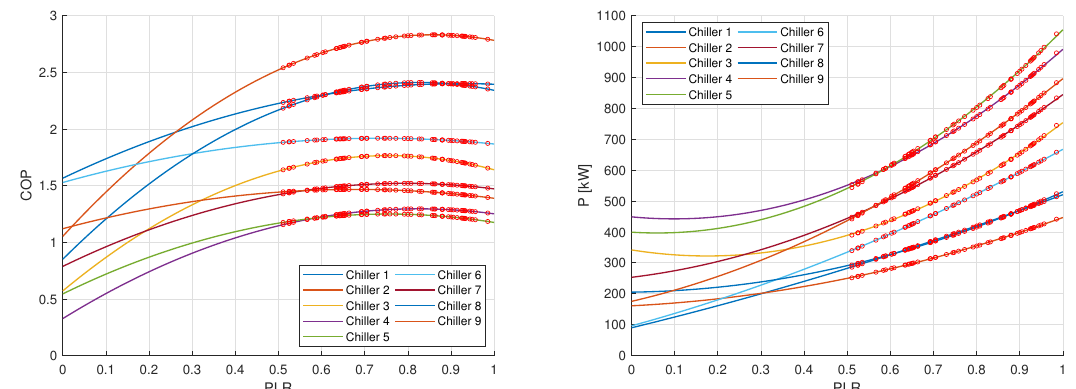
Figure A2. ( Left ): COP-PLR curves of chillers in case study 2. Red dots are the efficiency sampled data. ( Right ): P-PLR curves of chillers in case study 2. Red dots are the energy consumption data used for the